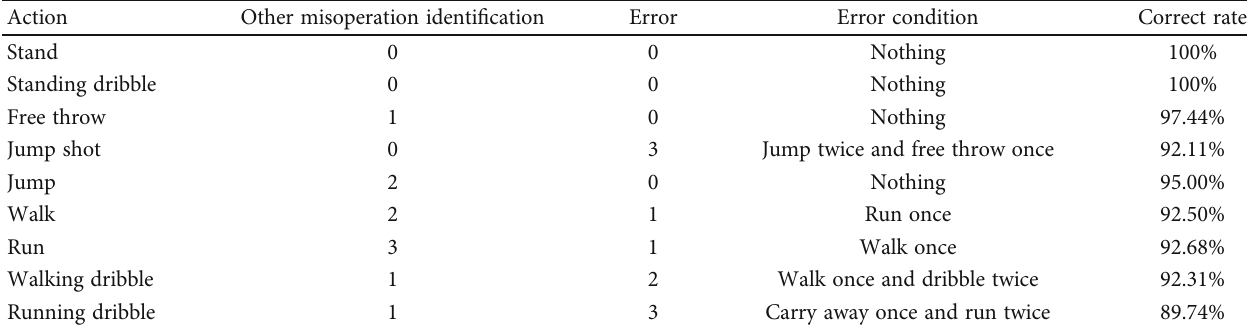
Table 6: Recognition accuracy of di ff erent side placement of decision tree veri fi cation set.